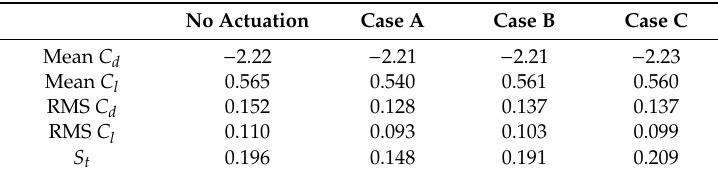
Table 2. Mean and RMS values of drag and lift coe ffi cients.